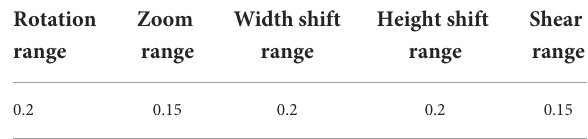
TABLE 5 Data augmentation